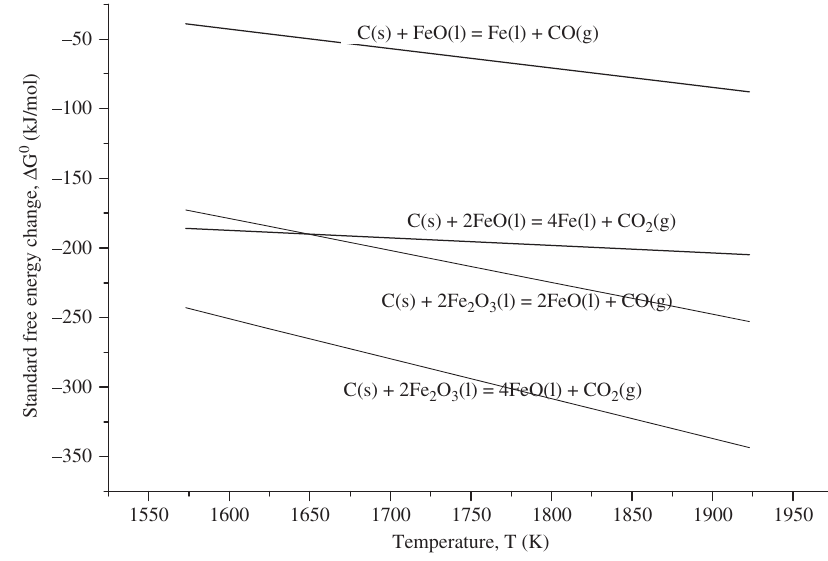
Figure 4: Standard free energy change as a function of temperature